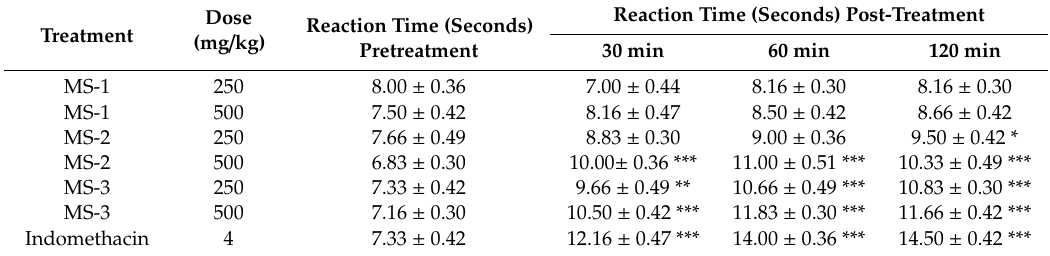
Table 2. Analgesic e ff ect of M. sinaica fractions on the hot plate reaction time in mice. Dose Reaction Time (Seconds) Treatment (mg / kg) Pretreatment